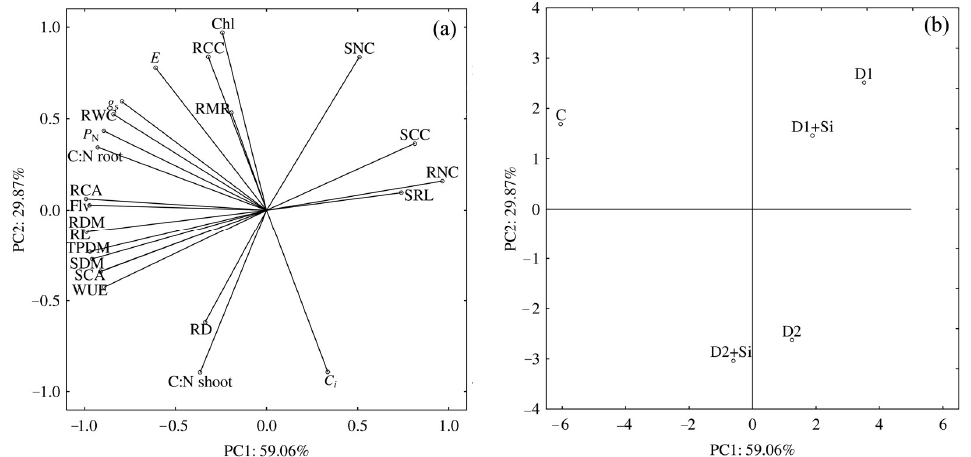
Figure 5. Results of principal component analysis (PCA) ( a ) presenting relationships between all analyzed parameters and ( b ) for the conditions of water and Si application (C—control, D1—spring